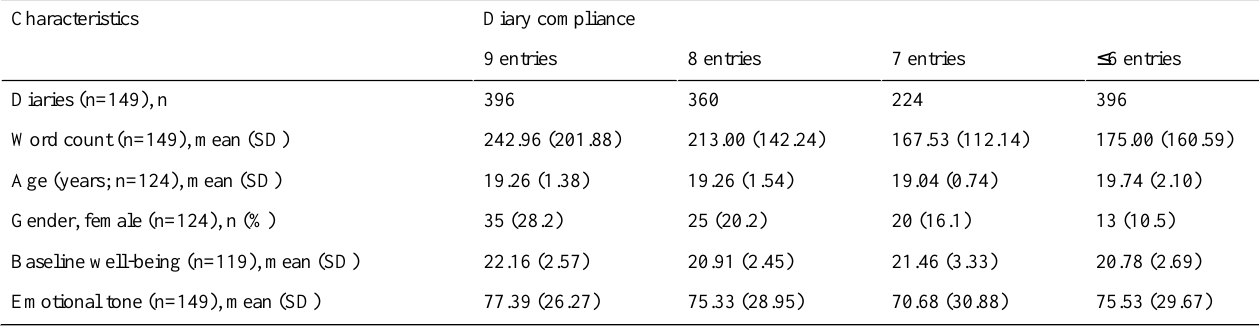
Table 3. Key sample and diary characteristics by diary-compliance subsamples.